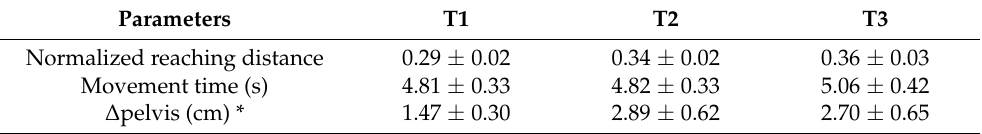
Table 3. Results for the kinematic parameters, mean and standard error of the whole population.